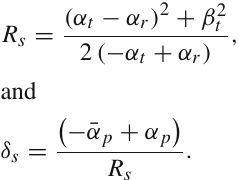
of the shadow (δ s ) and the size ( R s ) of the shadow image of the black